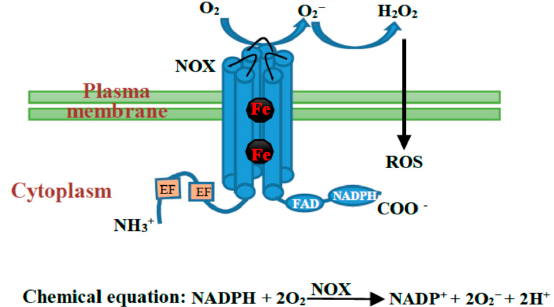
Figure 1. The schematic representation of NADPH oxidase (NOX) proteins in plants. The plant NOX proteins are often composed of a six-transmembrane domain, two hemes, a C-terminal flavin adenine dinucleotide (FAD) and NADPH hydrophilic domain, and two N-terminal EF-hand motifs. The NOX proteins obtain electrons from the cytoplasmic electron donor NADPH, and then transfer the electrons through the membrane to the extracellular electron acceptor O 2 to generate O 2 − .